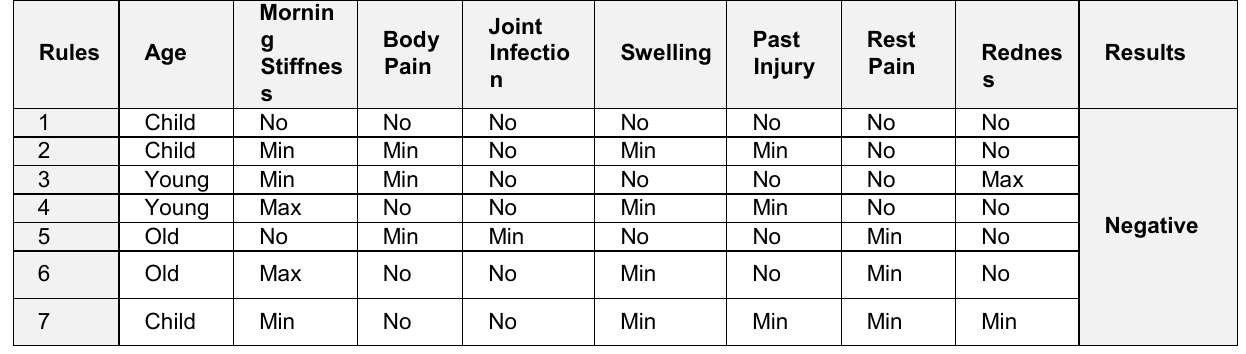
Table 7. Lookup table of Layer –I for DA-AH-MFES Expert